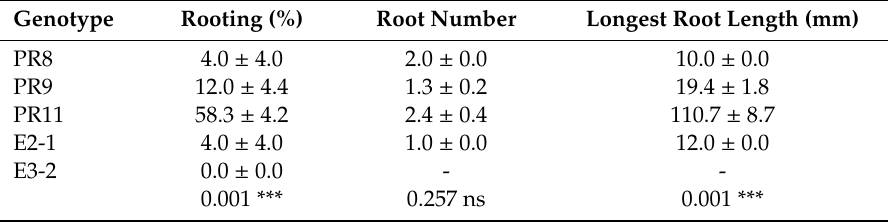
Table 3. Rooting ability of shoots derived from five tolerant Quercus ilex